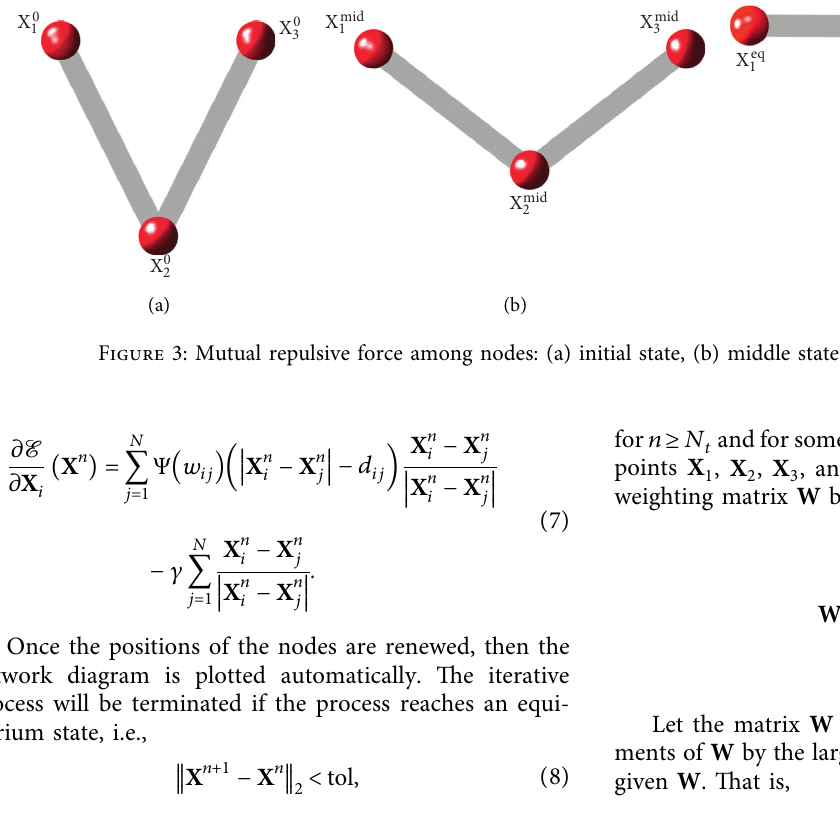
Figure 2: Two possible forces at nodes X n given d ij